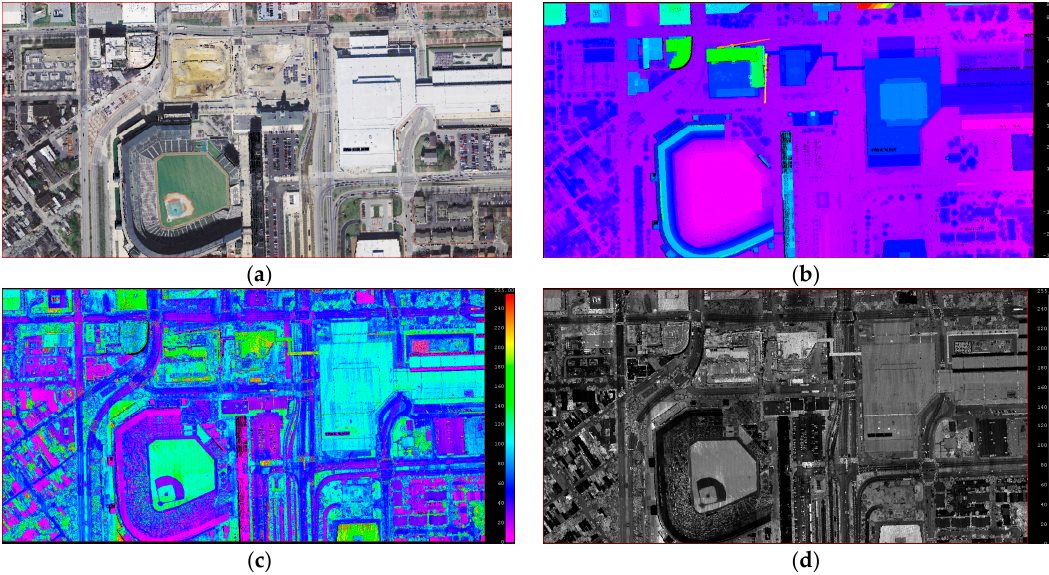
Figure 5. Original data. ( a ) Colored by RGB; ( b ) colored by height; ( c ) colored by intensity; ( d ) grayed by intensity.